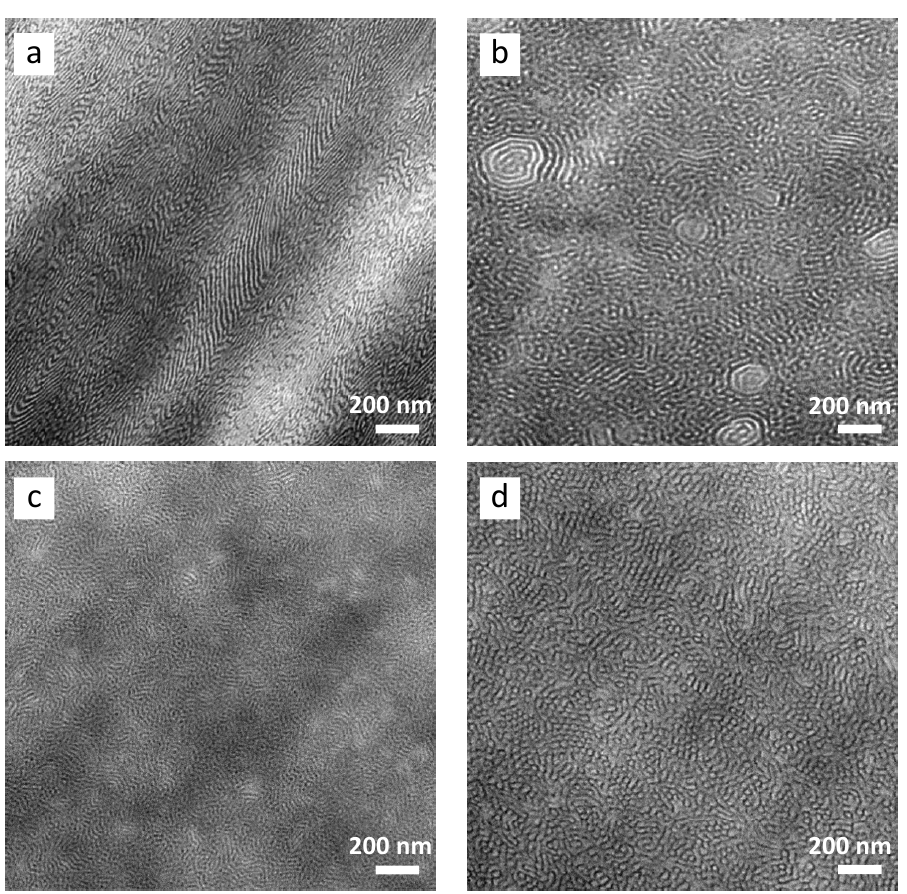
Figure 5. Transmission electron microscope (TEM) micrographs showing the morphology of virgin ST ( a ) and its chemically modified versions with varying epoxidation grades: epST-38 ( b ), epST-57 ( c ) and epST-82 ( d ).